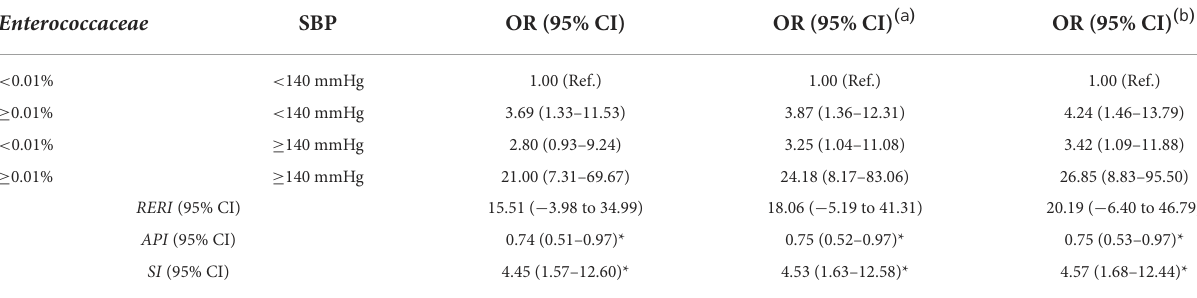
TABLE 2 Additive interaction analysis between SBP and family Enterococcaceae for first-ever ischemic stroke.